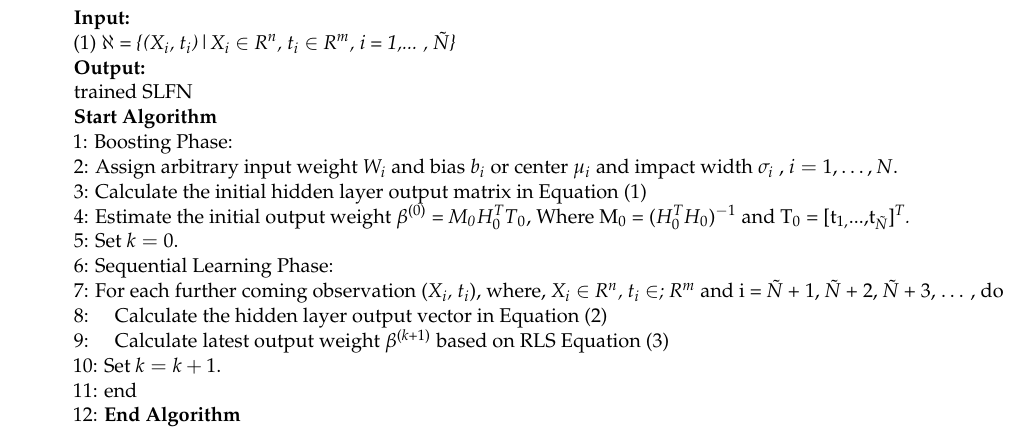
Algorithm 1. The pseudocode of the ELM (OS-ELM)